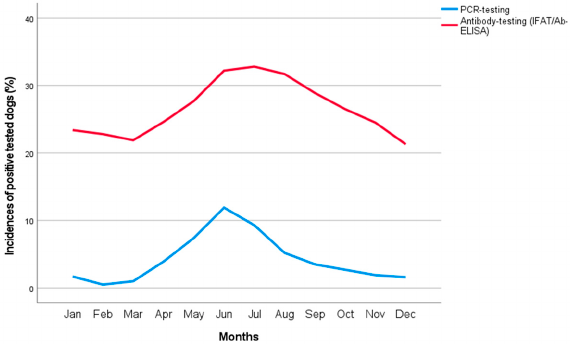
Figure 1. Monthly distribution of dogs that tested positive for Anaplasma phagocytophilum by direct (PCR; blue line) and indirect detection methods (IFAT, ELISA; red line) from 2008 to 2020. Binomial logistic regression was carried out to determine the effect of sex, age groups, and time of sample collection (by year and calendar month) on the results of PCR and antibody testing (Table 3). Correlations between predictor variables were low ( r < 0.70), indicating that multicollinearity was not a confounding factor in this analysis. Of the four variables entered into the regression model, two contributed significantly to positive re- sults of PCR testing (years of testing p = 0.001, months of testing p < 0.001), while all four had an impact on antibody testing (sex, age groups, years, and months of testing: p < 0.001 respectively). Male dogs were more likely to have detectable antibodies (OR = 1.269, 95%- CI [1.228, 1.312]), while sex had no statistically significant effect on PCR results ( p = 0.995). Older age (> 7 years) also increased the rates of antibody detection (OR = 2.392, 95%-CI [2.314, 2.472]) but did not affect PCR results ( p = 0.122). The odds of testing positive by either PCR (OR = 1.029, 95%-CI [1.011, 1.047]) or antibody testing (OR = 1.056, 95%-CI [1.051, 1.060]) increased over time (Table 3). Table 3. Binominal logistic regression analysis in dogs tested for Anaplasma phagocytophilum by di- rect (PCR) and indirect detection methods (IFAT, ELISA) in 74973 dogs with known sex, age, years of testing, and months of testing from 2008 to 2020.